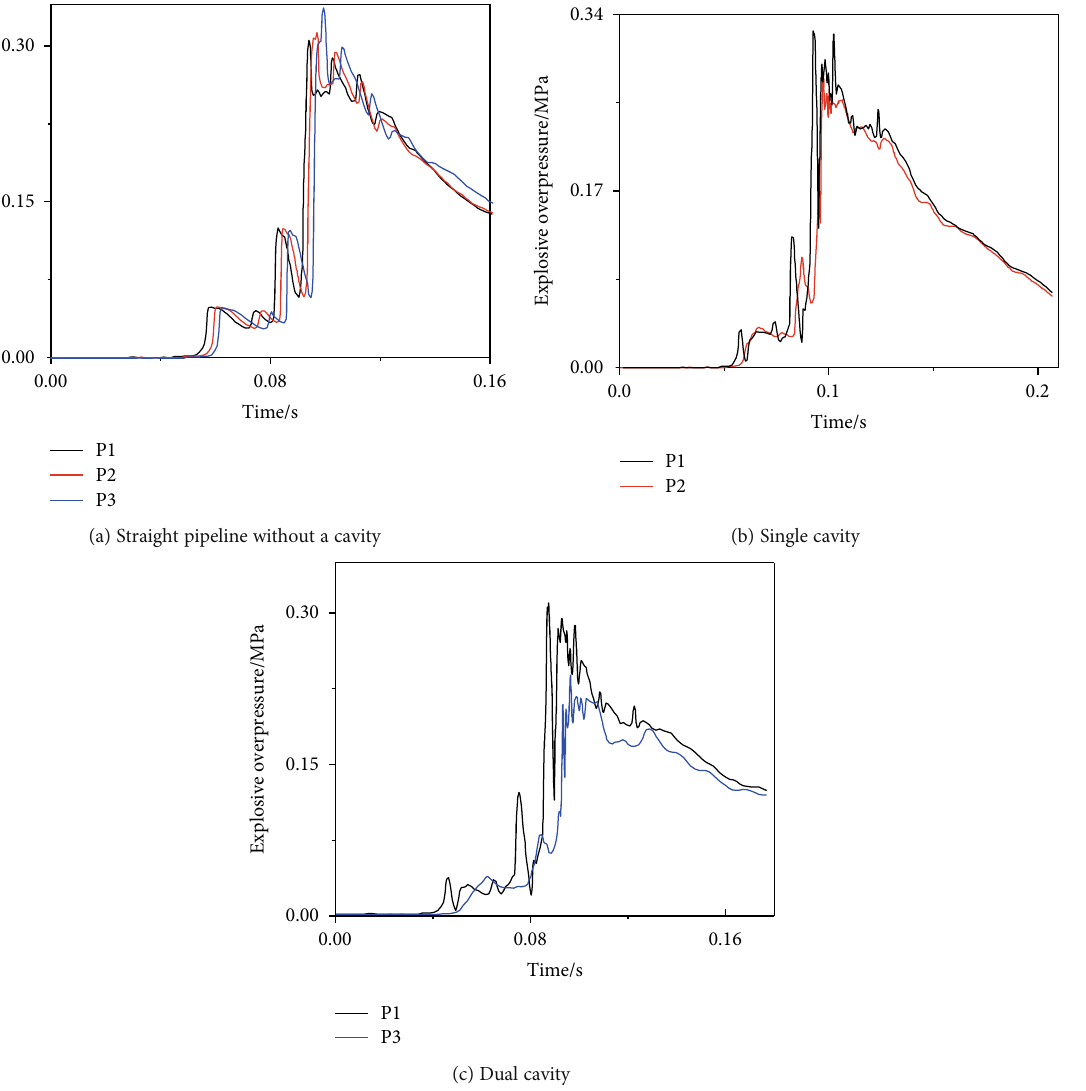
Figure 7: Shock wave overpressure versus time.